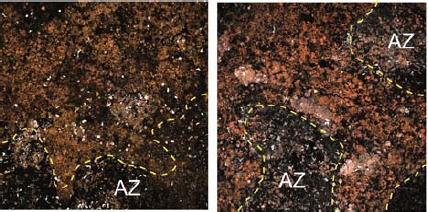
Additional examples of CD14-stained RPE flatmountsDOI: